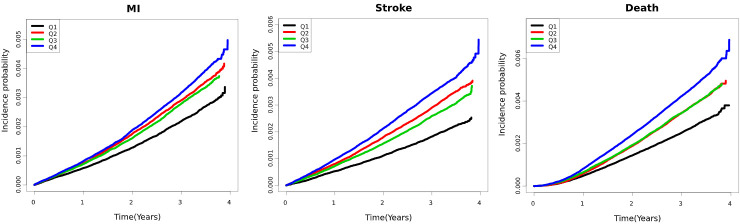
Incidence probability of MI, stroke, and death according to GFR variability.Curves indicate the Kaplan-Meier estimates of the risk of MI, stroke and death by the quartiles of the eGFR variability. The X axis indicates time (years), and the Y axis indicates the incidence probability (%) of the outcomes.